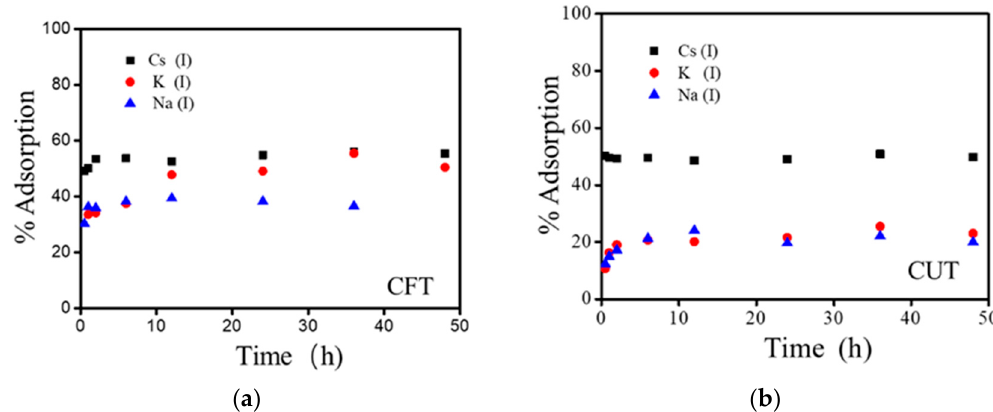
Figure 3. Effect of time of alkali metal ion adsorption on ( a ) crosslinked fresh tea leaves (CFT) adsorbents and ( b ) crosslinked used tea leaves (CUT) adsorbents, adsorbent weight = 0.05 g, solution volume = 10.0 cm 3 , [M + ] i = 1.0 mM, pH e = 2.5, shaking time = several hours.